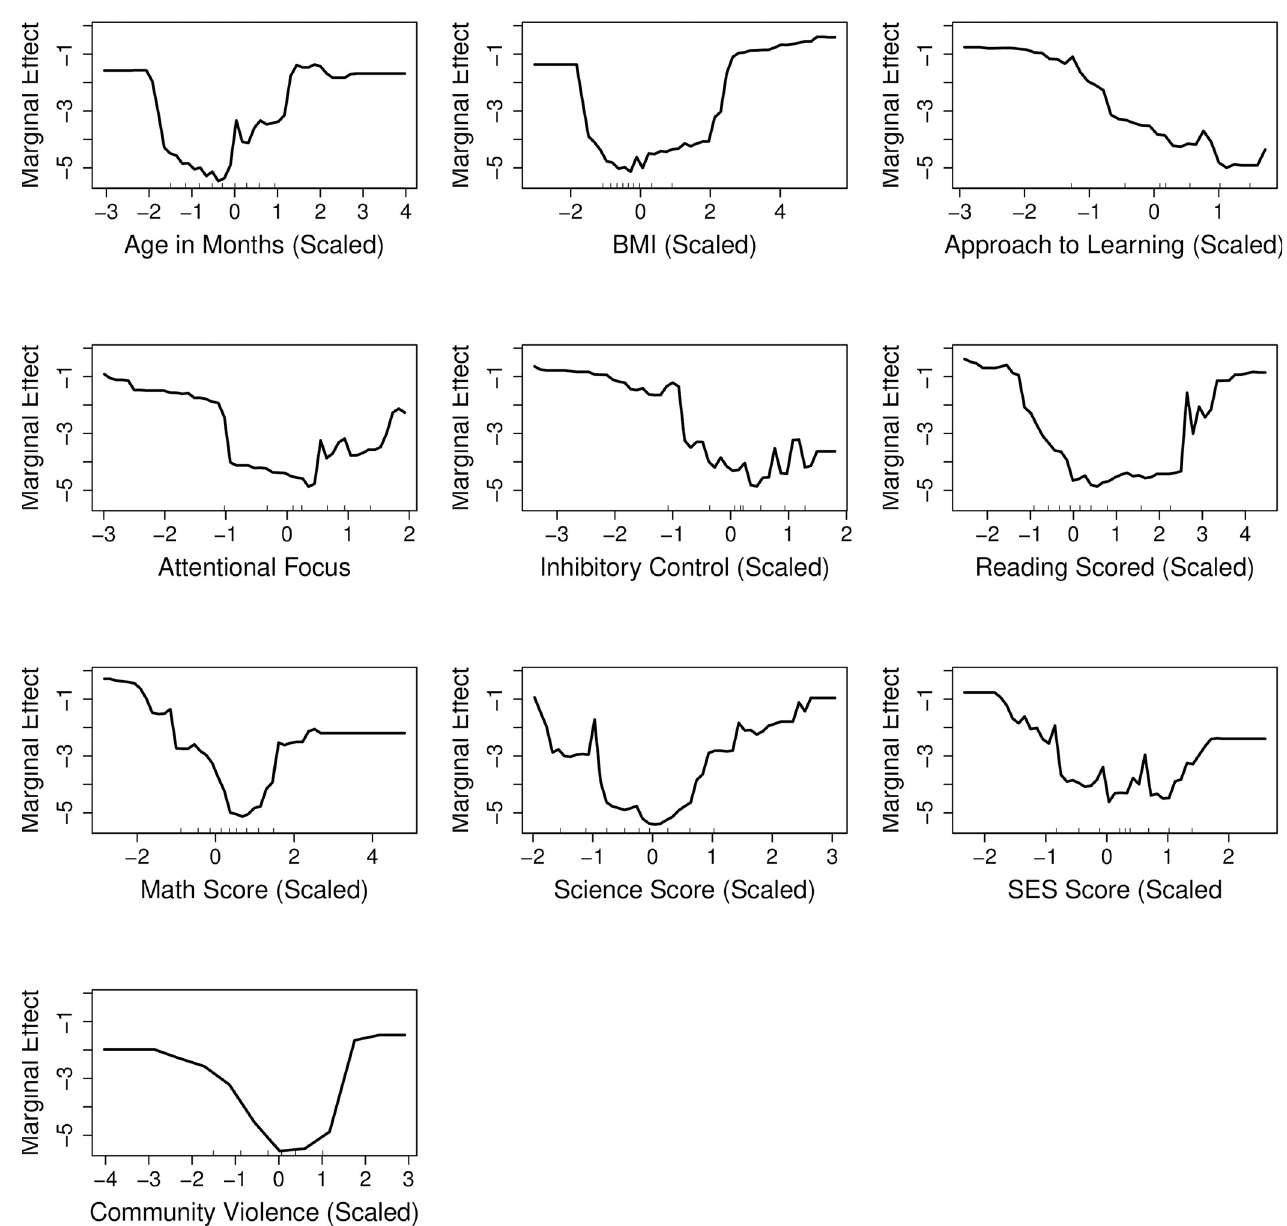
Fig 7. Partial dependence plots showing the dependence of the top ten important variables with prediction of internalizing problem behaviors. The y- axis represents the log odds of predicted probability for a fixed value of the variable of interest, conditional on all other variables (marginal effect). The x-axis represents the observed values of the variables scaled to have mean of zero and standard deviation of 1. BMI = body mass index, SES = socioeconomic